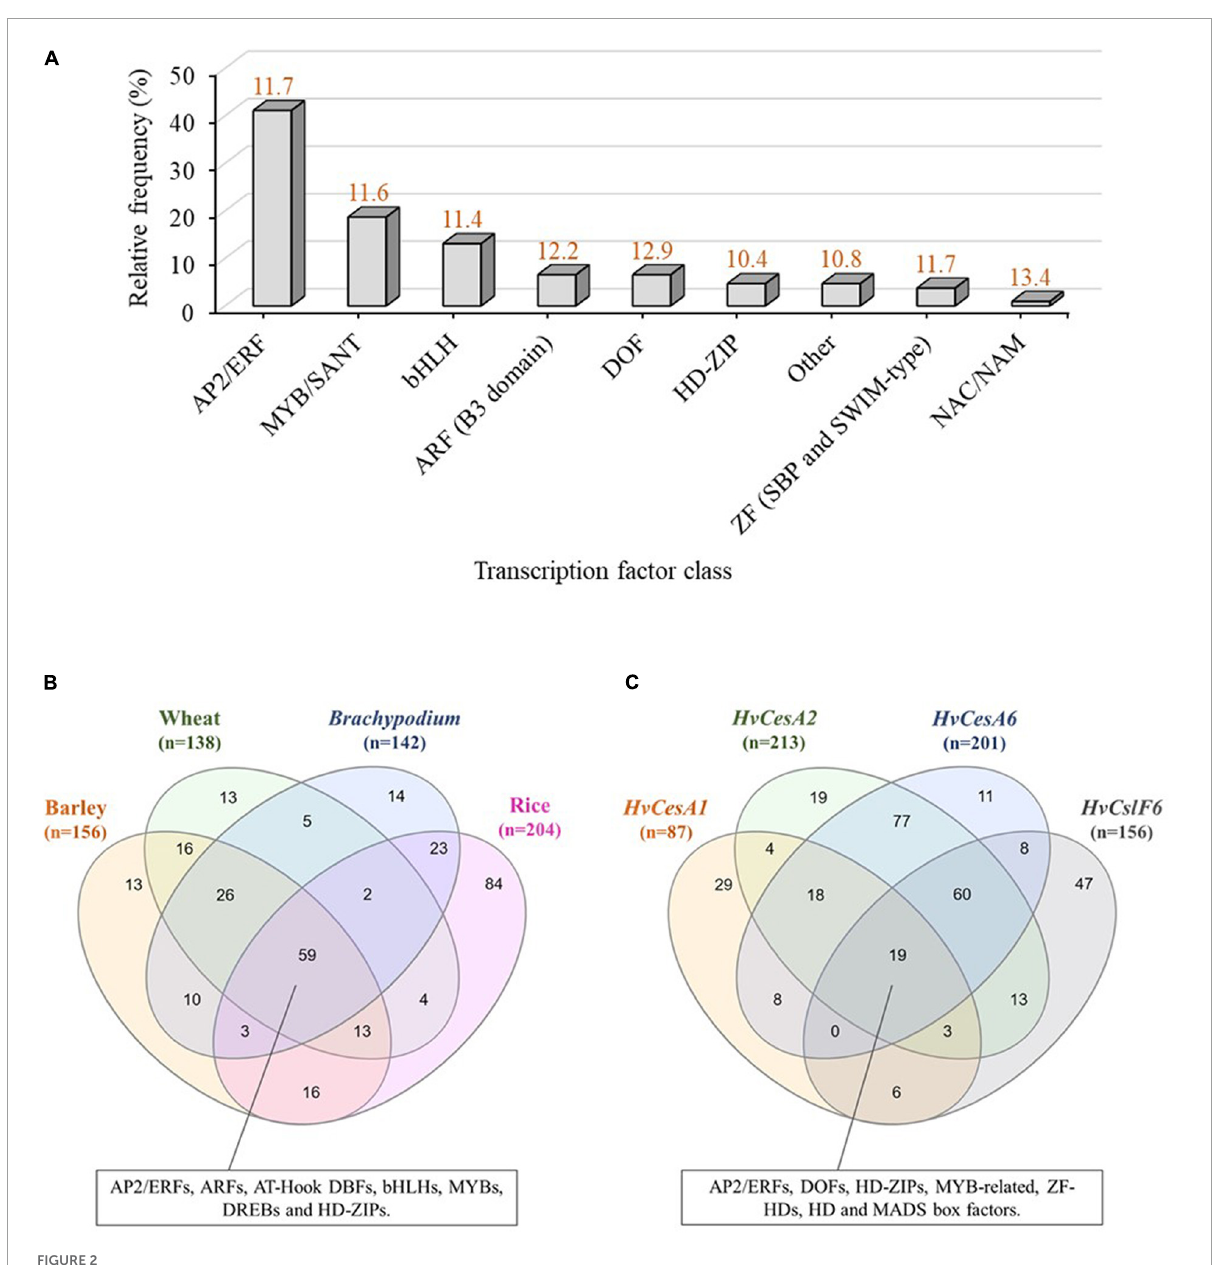
FIGURE2 In-silico analysis of transcription factor binding sites (TFBSs) in the CslF6 promoter. (A) TFBS predictions identified within a 1,000 bp upstream region of HvCslF6 start codon using JASPAR (Fornes et al., 2020) . TFBS predictions were grouped into TF classes and expressed as relative frequency % of TFBSs corresponding to a particular TF family from the total TFBSs predicted ( n = 107, after applying a ≥ 10 matrix score cut-off to maximize TFBS prediction accuracy). Other TF class indicate a mixed class of low-represented TFBSs (frequency within HvCslF6 full length promoter ≤ 2%). Average prediction scores for each TF class are shown in orange on top of each bar and were inferred from position frequency matrices (PFMs) and TF flexible models (TFFMs) in JASPAR. (B) Venn diagram of TFBS predicted within putative CslF6 promoter regions ( – 1,000 bp) across barley ( Hordeum vulgare ), wheat ( Triticum aestivum ), Brachypodium distachyon and rice ( Oryza sativa ). (C) Venn diagram of TFBSs predicted within HvCesA1 , HvCesA2 , HvCesA6 , and HvCslF6 putative promoter regions ( – 1,000 bp) with identical filtering as described above. Venn diagrams were created using InteractiVenn (Heberle et al., 2015)